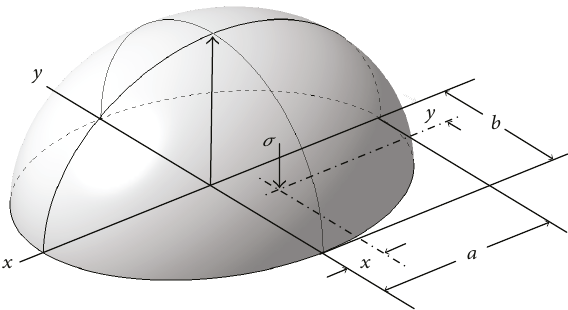
Figure 5: Compressive stress distribution of the ball-raceway